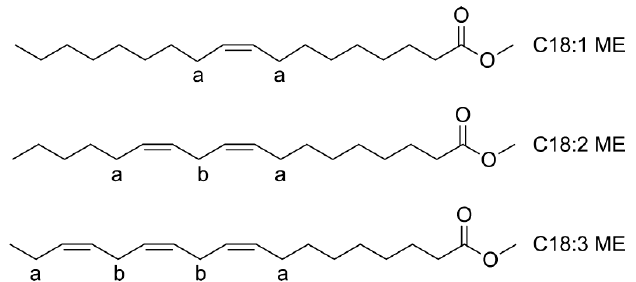
Figure 1. Common unsaturated C18 methyl esters in biodiesel: C18:1 ME, oleic acid methyl ester, C18:2 ME, linoleic acid methyl ester, and C18:3 ME, linolenic acid methyl ester, with ( a ) allylic positions and ( b ) bis-allylic positions.